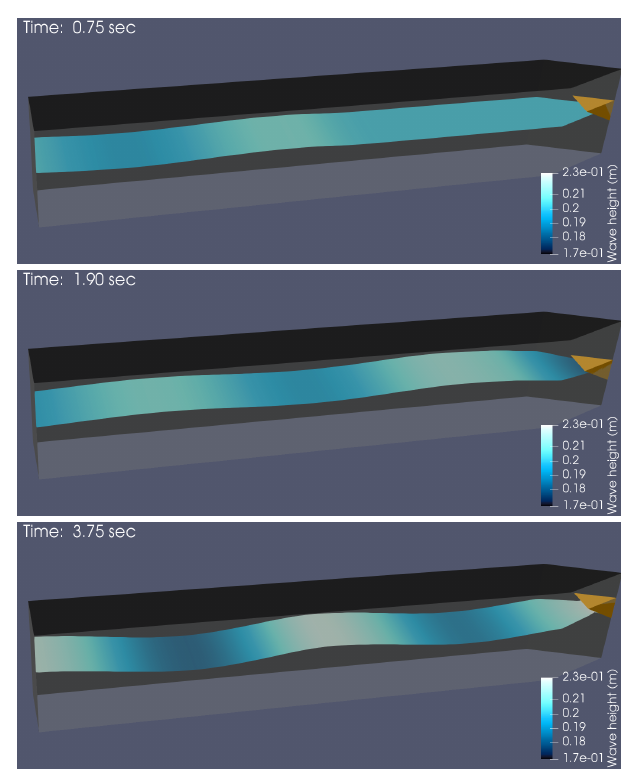
Fig. 4. Snapshots of the numerically computed free surface h ( x,y,t ) = H ( x,y ) + η ( x,y,t ) (colour denotes height in meters, with initial still water level H 0 = 0 . 2m ), as it evolves in the wavetank with V-shaped contraction (times shown on the pictures). The buoy resides in the corner of the contraction and is shown using orange colour.